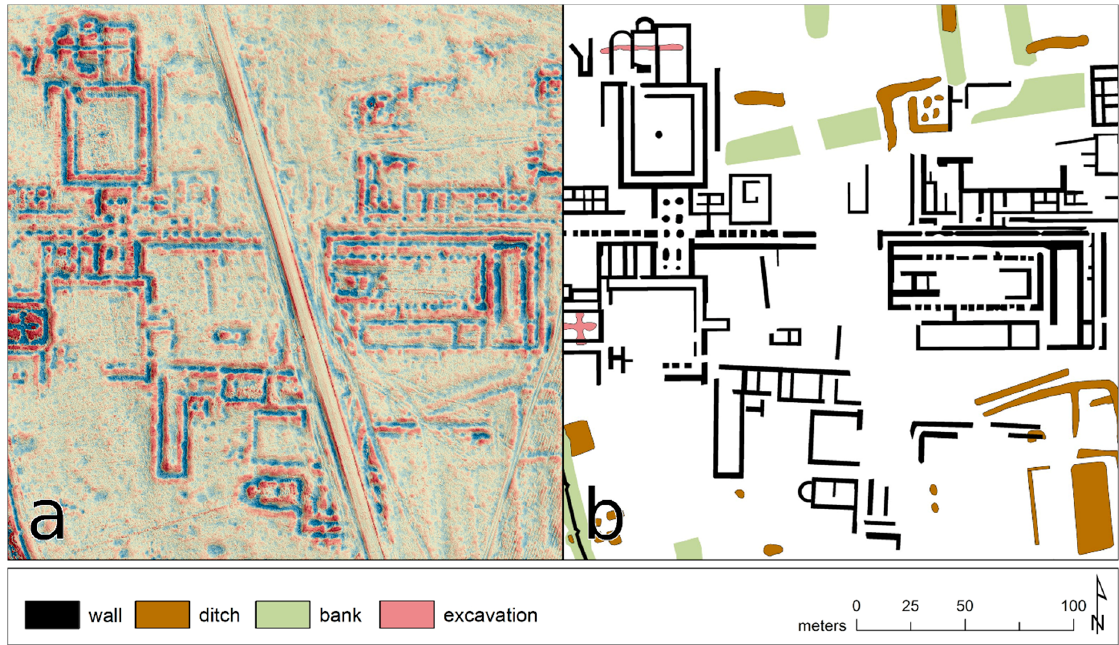
Figure 12. ( a ) Detail of a fused DSM visualization: a simple local relief model (circular kernel with 40 cells radius, ( − 0.15 m, 0.15 m) clip, blue-yellow-red colour map) merged with a multidirectional hillshade (35° solar elevation, vertical exaggeration factor of 3) using two iterations of the “hard light” blending mode with varying opacity levels. The contrast of both source layers was slightly altered before the initial blending. ( b ) Corresponding archaeological interpretation.